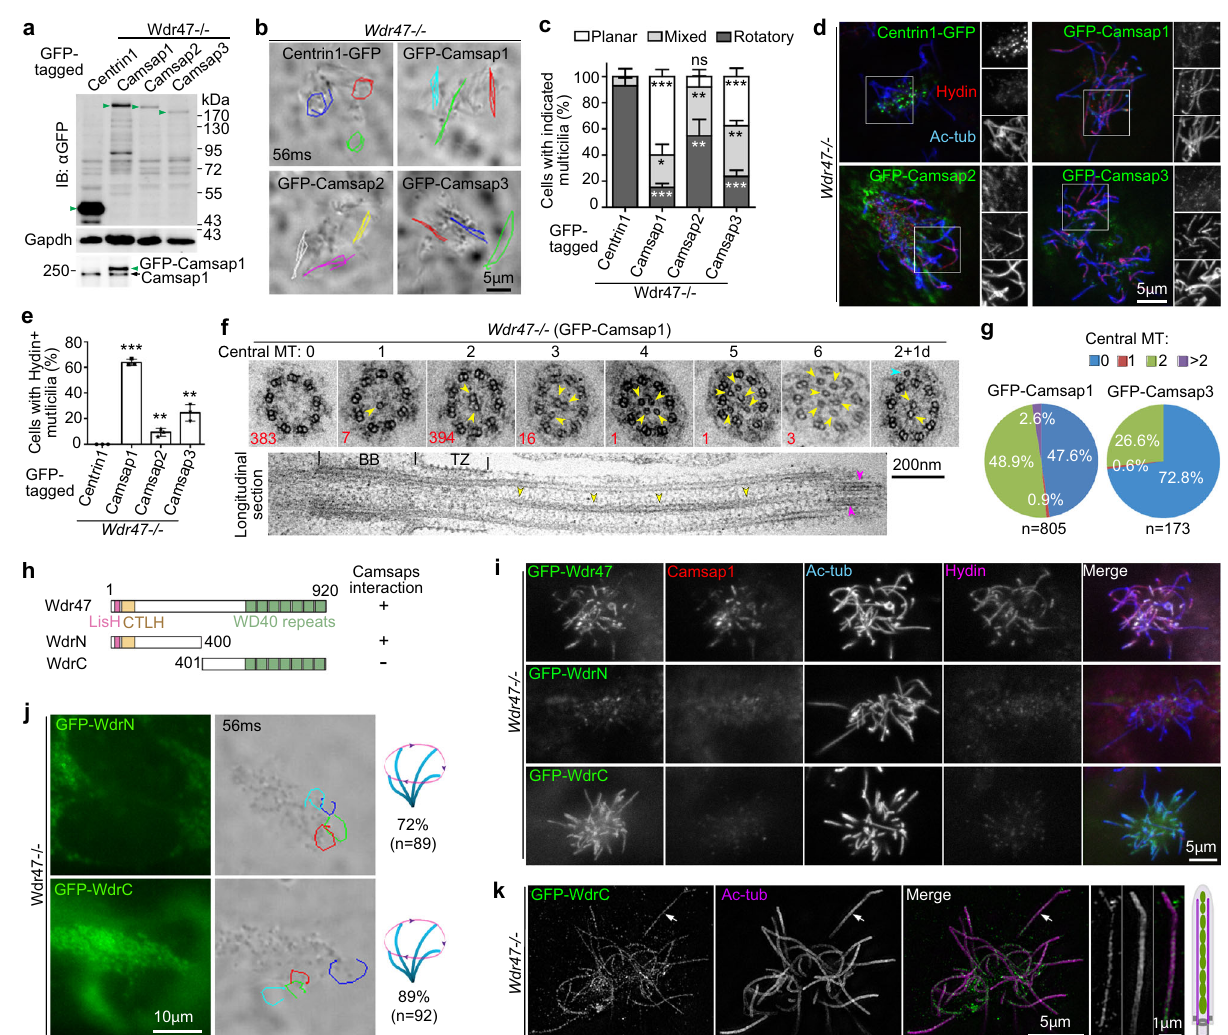
Fig. 5 Wdr47 concentrates Camsaps to the central lumen for ef fi cient and proper central MT formation. a Expression levels of exogenous Camsaps and Centrin1 (arrowheads) in Wdr47 -/- mEPCs. Wdr47 − / − mEPCs were infected with lentivirus at day − 1, day 2, and day 5 to express GFP-tagged Camsaps or Centrin1 (negative control). The cells were harvested at day 10 for immunoblotting (IB) or assays in b – g . >80% of the cells were usually GFP-positive. The average GFP-Camsap1 level was estimated to be 2.3-fold over that of endogenous Camsap1 when IB was performed using anti-Casmsap1 antibody (bottom panel). Gapdh served as loading control. n = 3 biological replicates. b , c Effects on ciliary beat pattern. Trajectories of three cilia during the fi rst 56 ms of